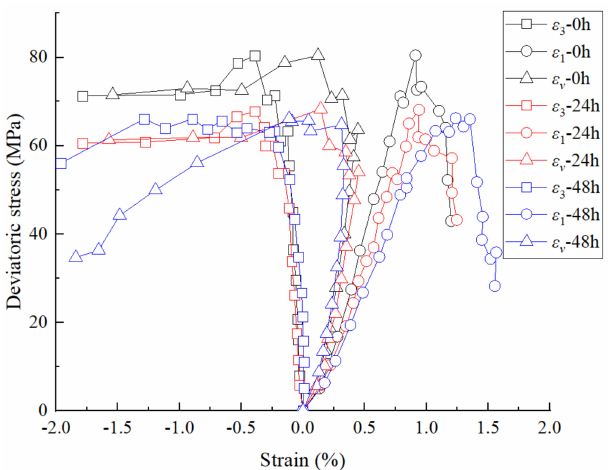
Figure 6. Complete stress − strain curve of the lamellar shale samples for β = 30 ◦ under confining pressure of 15 MPa, after different hydration